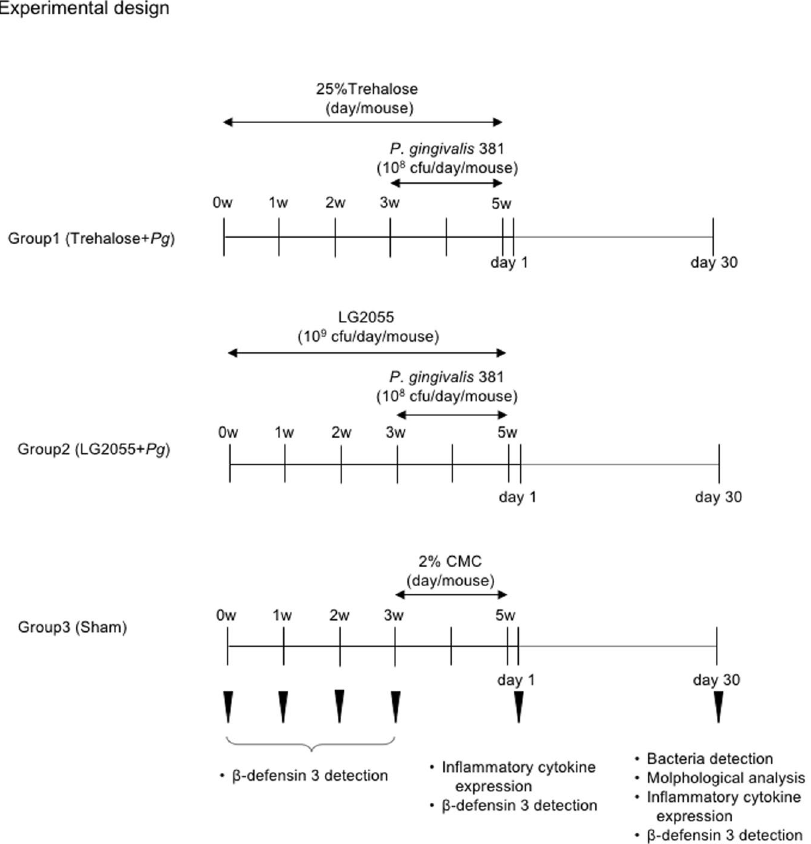
Figure 6. Experimental procedure. Eight-week-old female BALB/c mice were randomly divided into three groups (n = 36 per group); groups 1 and 2 were orally intubated with 25% trehalose or LG2055 (1 × 10 9 CFU/200 μ L/mouse) throughout the experiment once per day for 5 weeks. After administration for 3 weeks, mice were orally infected with P . gingivalis (1 × 10 8 CFU/100 μ L with 5% CMC/mouse) once per day for 2 weeks. The third group received 5% CMC without oral intubation. Mice were sacrificed 0, 1, 2, and 3 weeks (n = 5 at each time point) after LG2055 administration for a mouse β -defensin-3 assay, and were sacrificed 1 and 30 days (n = 8 at each time point) after P . gingivalis infection for mouse β -defensin-3 assay, GMC